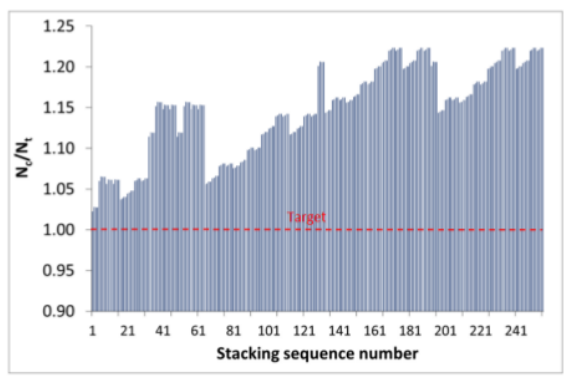
Figure 11: The first mode shape of [±45 2 ] s laminated plate (B4 speci- men); m = 2, n = 1 , top view (left) and side view (right). The contour indicates ratio of w / w max